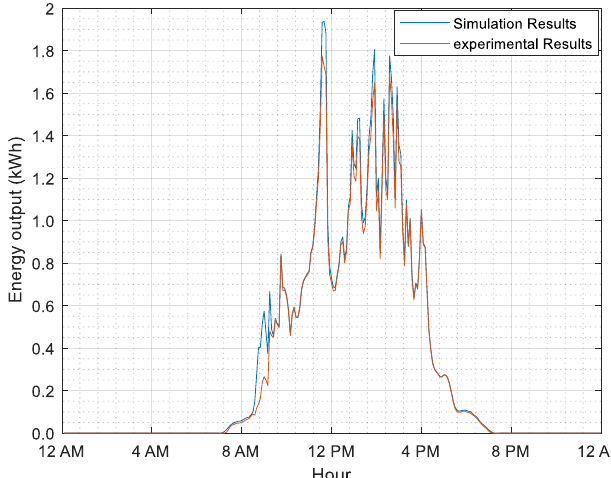
Clean Technol. 2020 , 2 FOR PEER REVIEW Figure 3 . Verification of the PV mathematical model . Figure 3. Verification of the PV mathematical model.